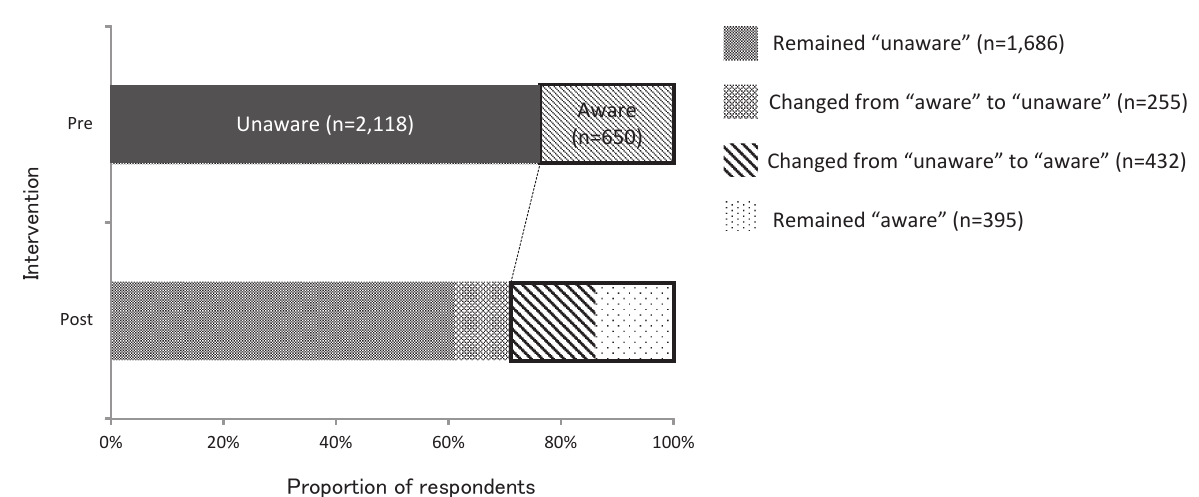
Figure 1. Proportion of respondents who selected fi ve correct answers in the intervention areas (Akita & Kure) in the pre- and the post-intervention